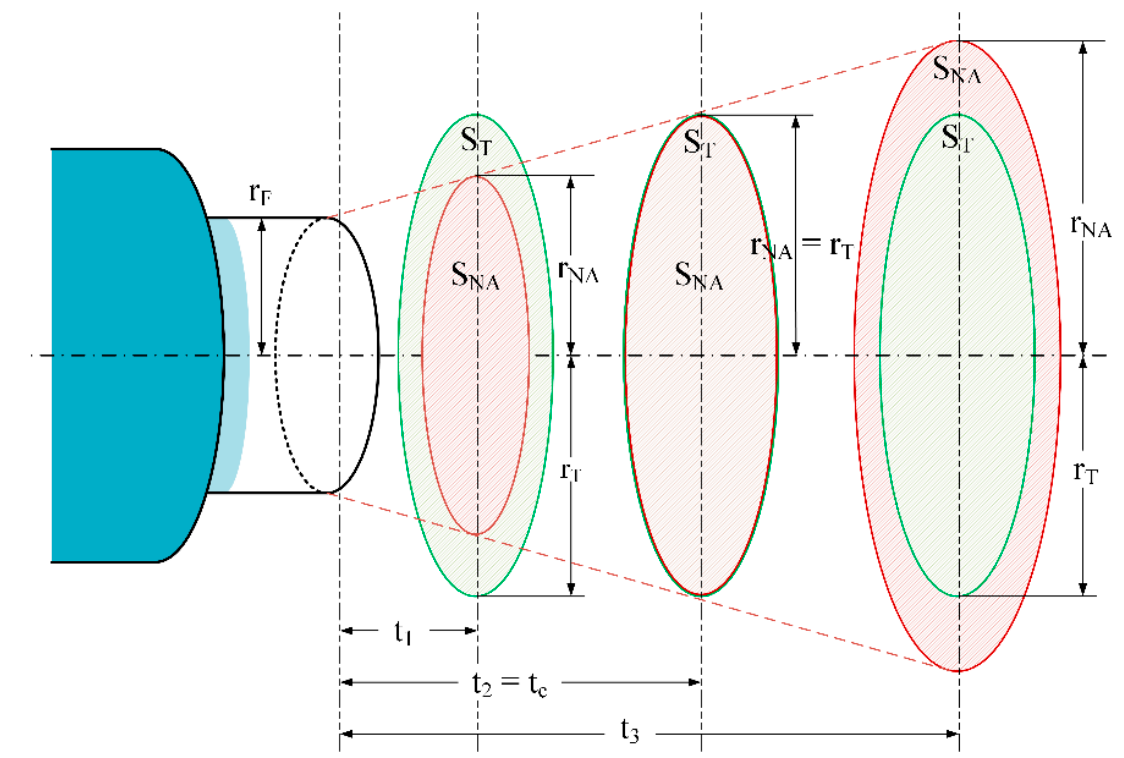
Figure 7. Relations between the numerical aperture radius r NA and the target radius r T for different t distances.